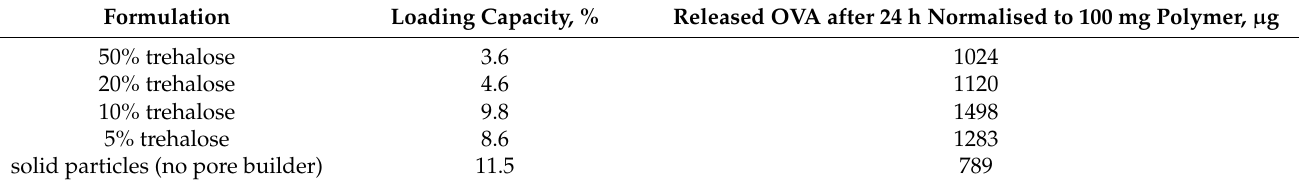
Table 3. Effect of trehalose addition on OVA loading capacity and OVA